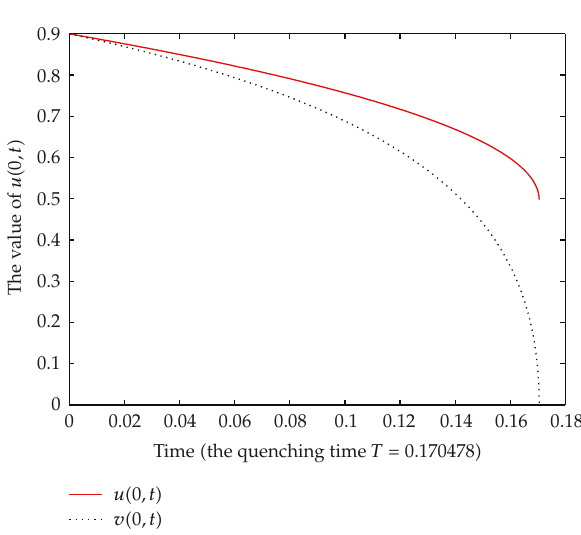
Figure 5: Evolution at the point x 0 (cid:3) 0 of the solution (cid:5) p 1 (cid:3) q 1 (cid:3) q 2 (cid:3) 1 , p 2 (cid:3) 3 (cid:6) .